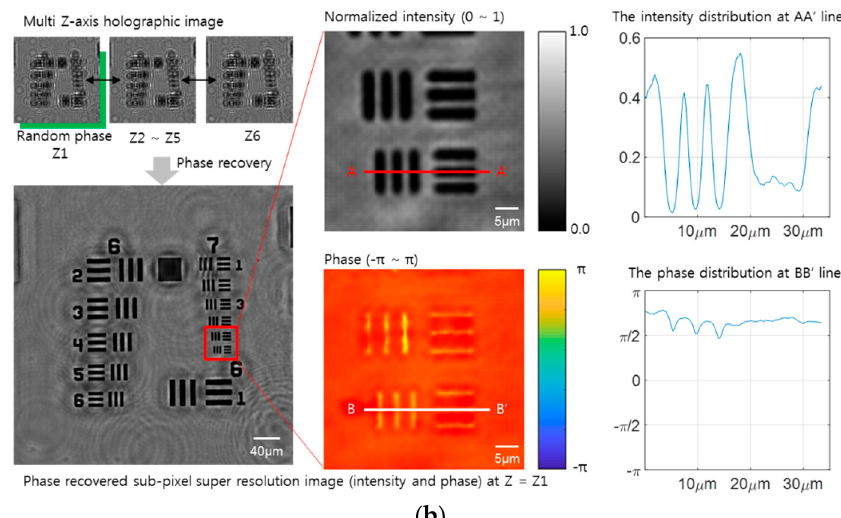
Figure 4. Comparison of two phase recovery algorithms, a single-height and an iterative multi-height phase recovery process. ( a ) A single height subpixel super-resolution hologram image and its reconstruction. The magnified image shows the intensity and phase after single-step phase recovery, which is set with a random phase value. The twin image artifacts are reduced in the reconstructed image and compared with no phase recovery. ( b ) An iterative phase recovery image using a set of multi-height holographic images. With a random phase image from the first Z -height hologram, the forward propagation performs and compares the next Z -height hologram intensity to renew the phase using the iterative reconstruction method. The phase recovered super-resolution hologram shows a significant reduction of the twin image artifacts. The full information of the hologram intensity and phase shows a similar profile following the sliced graphs, which are utilized for the 3D image generation. The effect of removing artifacts through the phase recovery process shows a significant enhancement in resolution.